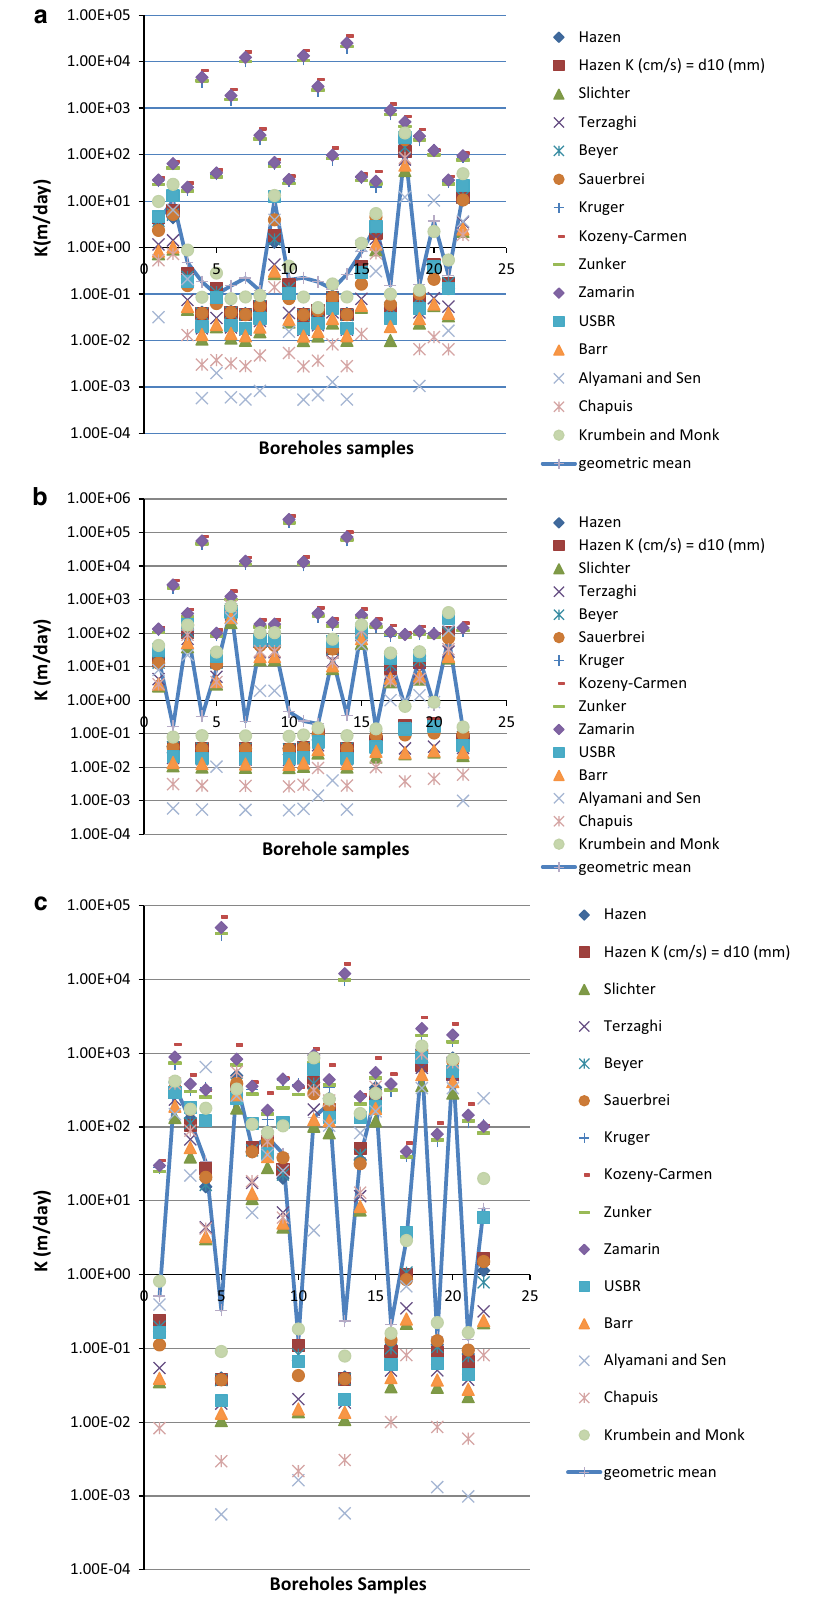
Fig. 4 Estimated hydraulic conductivity using the empiri- cal methods for six layers for 22 boreholes (symbols) with geometric mean (blue line). ( a ) Layer 1, ( b ) Layer 2, ( c ) Layer 3, ( d ) Layer 4, ( e ) Layer 5 and ( f ) Layer